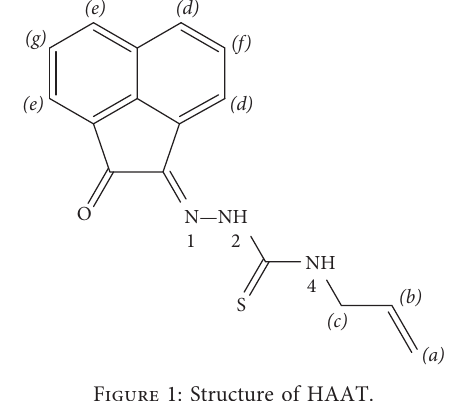
Figure 1: Structure of HAAT. Table 2: Infrared spectral date of HAAT and its metal complexes.